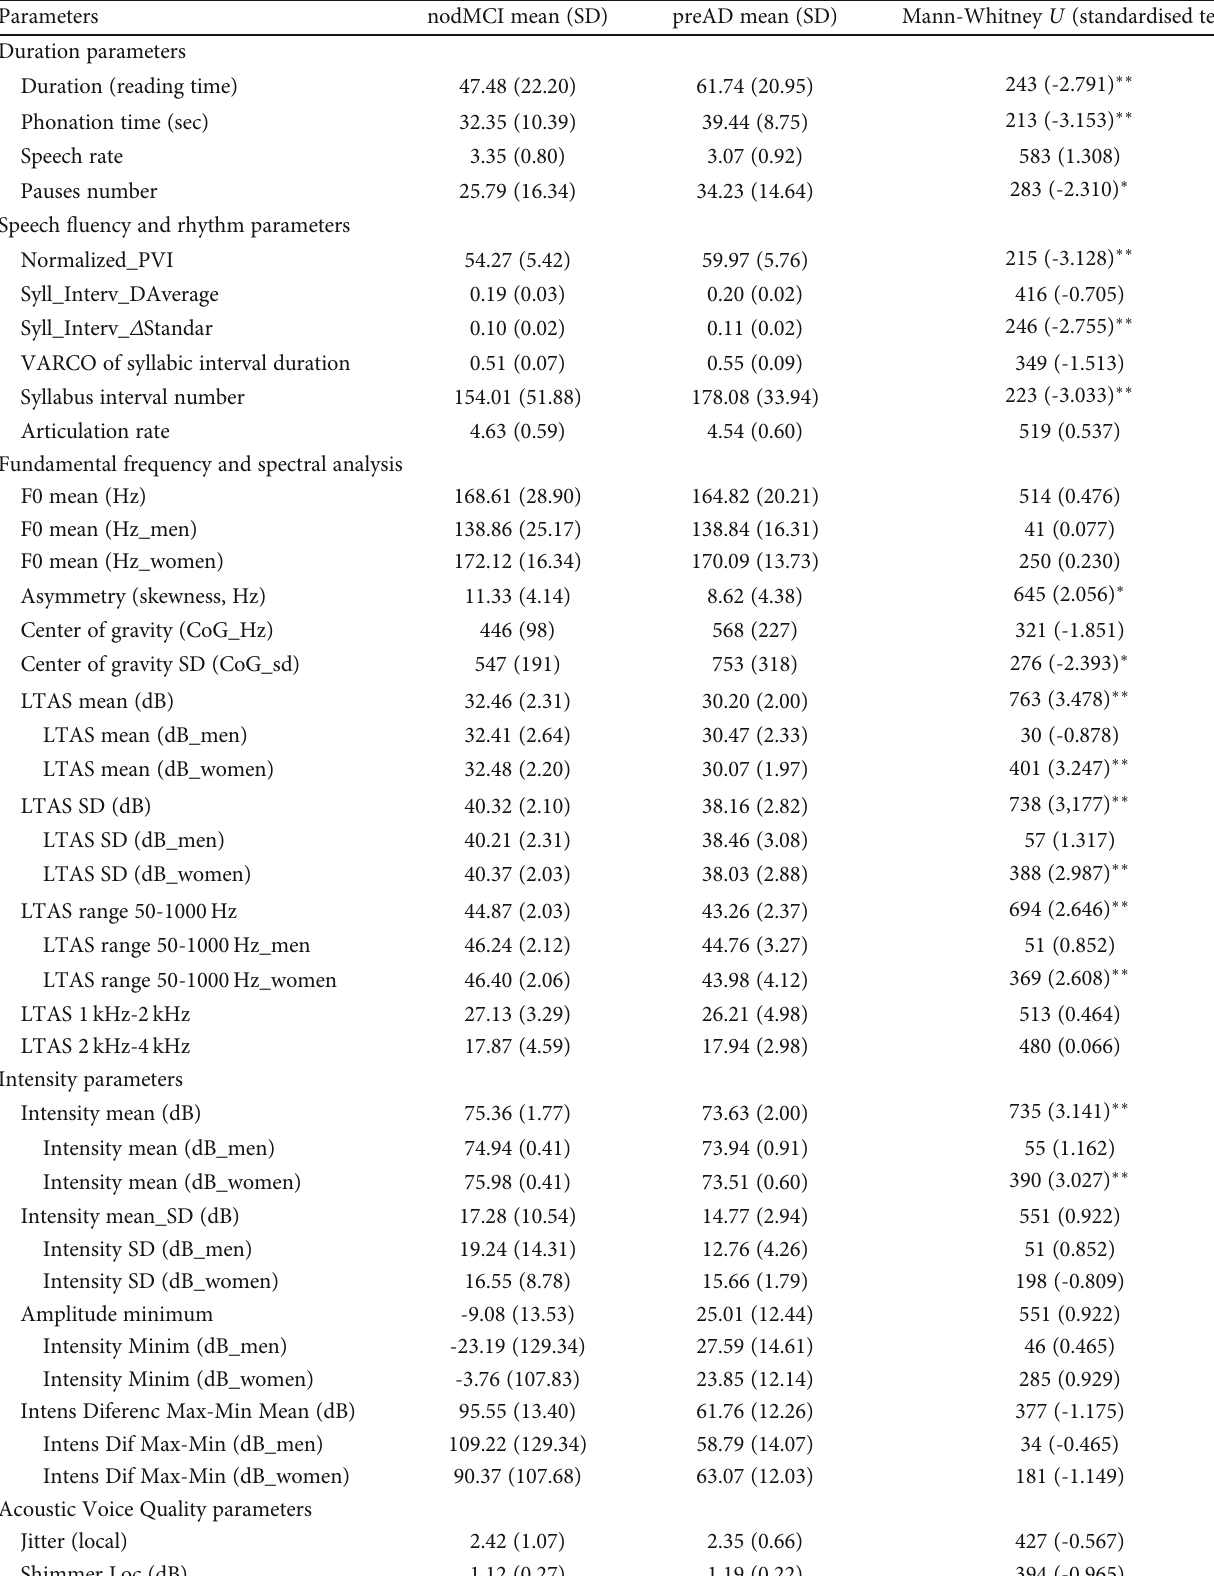
Table 2: Comparison of the voice parameters used between older people with nondegenerative MCI and those expected to develop AD. Mann-Whitney U test of independent samples and means of the two